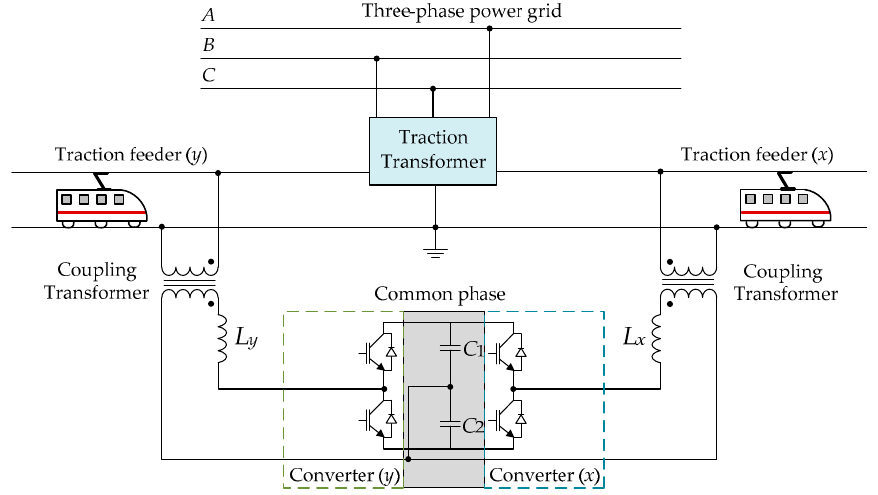
Table 7. Components quantities of the HB-RPC.